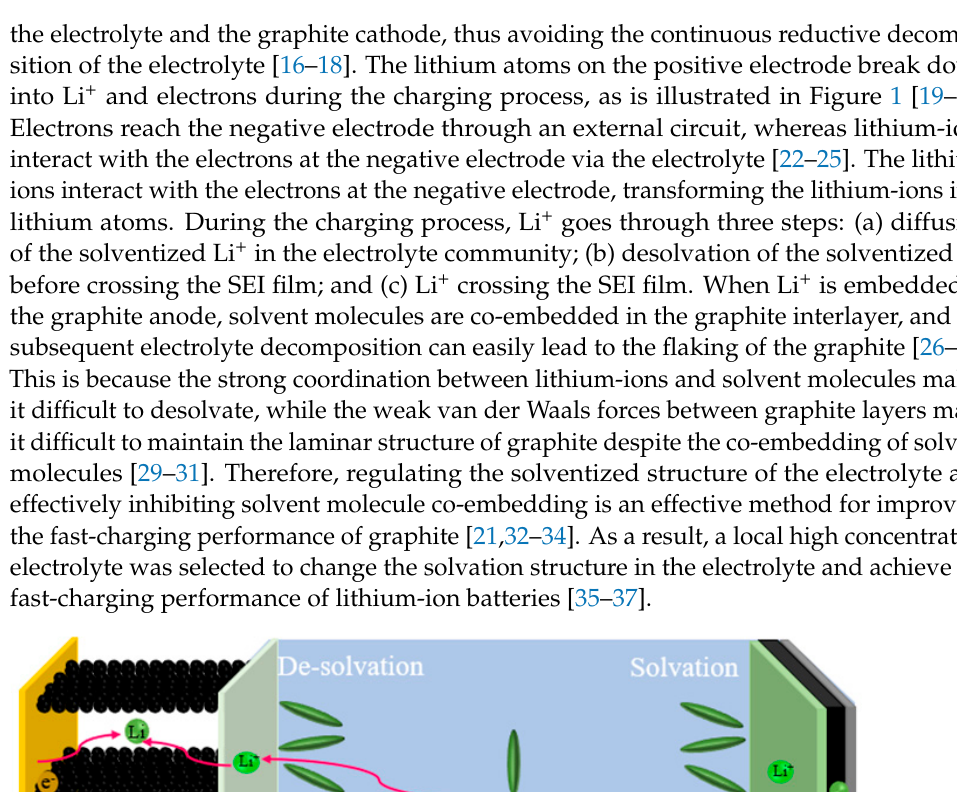
Table 1. The prepared electrolytes used in experiments.